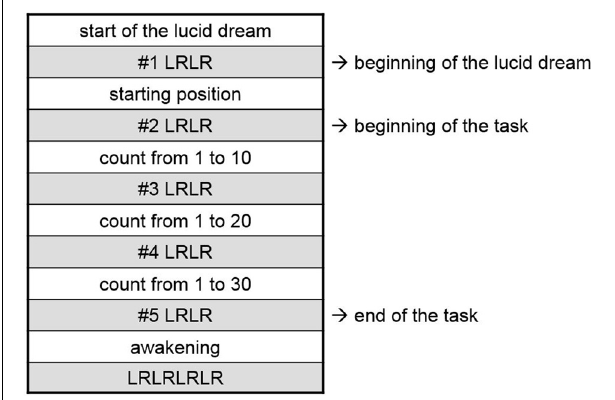
FIGURE 1 | Experimental protocol for the lucid dream task